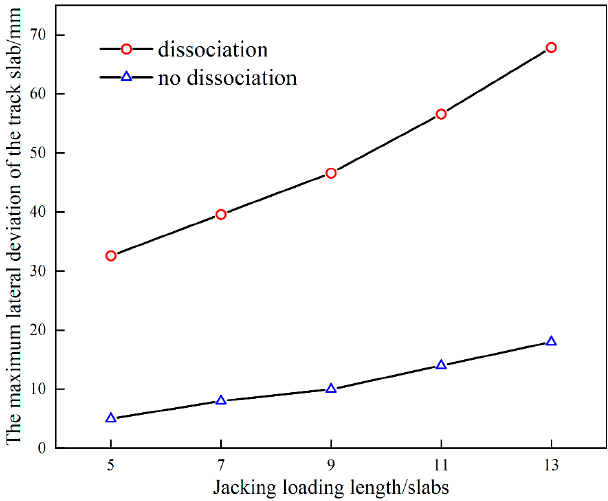
Figure 8. Influence of jacking loading length during multi-point jacking.